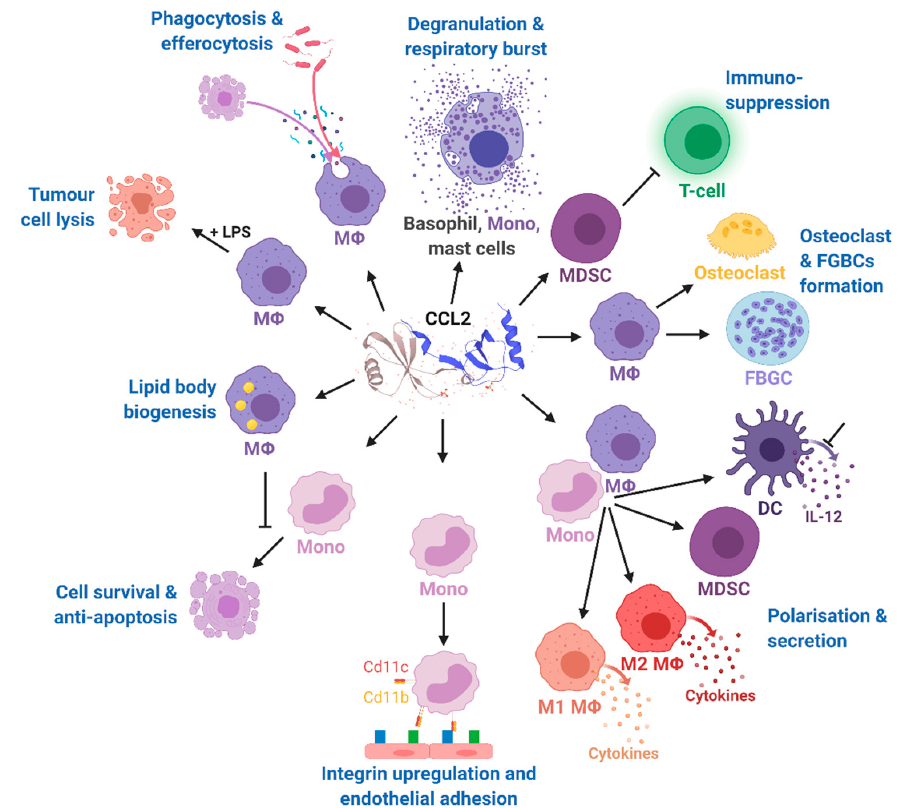
Figure 3. Effects of CCL2 on different immune cell types. Mono, monocytes; M Φ , macrophages; DC, dendritic cells; FBGCs, foreign body giant cells; MDSC, myeloid-derived suppressor cell; IL-12, interleukin 12; LPS, lipopolysaccharide; CD11b, cluster of differentiation molecule 11B; CD11c, cluster of differentiation molecule 11C. The CCL2 structure was taken from uniprot [86]. Modified from Gschwandtner M. et al. [60] using